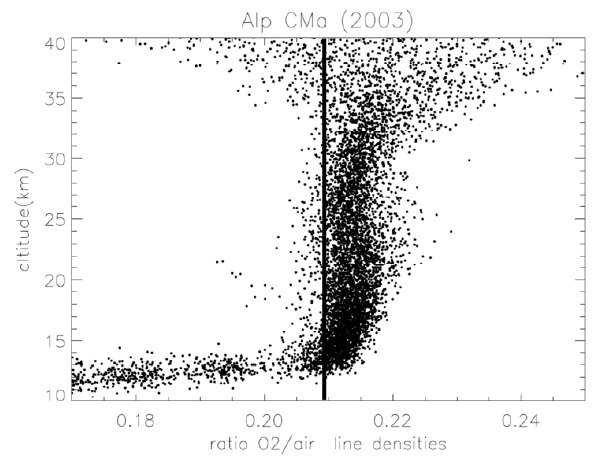
Fig. 41. A number of occultations of Sirius are considered during 2003. Each point is the ratio N (O 2 )/ N air of the retrieved line density N (O 2 ) from GOMOS to the line density N air computed from ECMWF. A vertical bar is placed at the value 0.20946, the normal O 2 mixing ratio. There is an unexplained bias where the measurements are better.